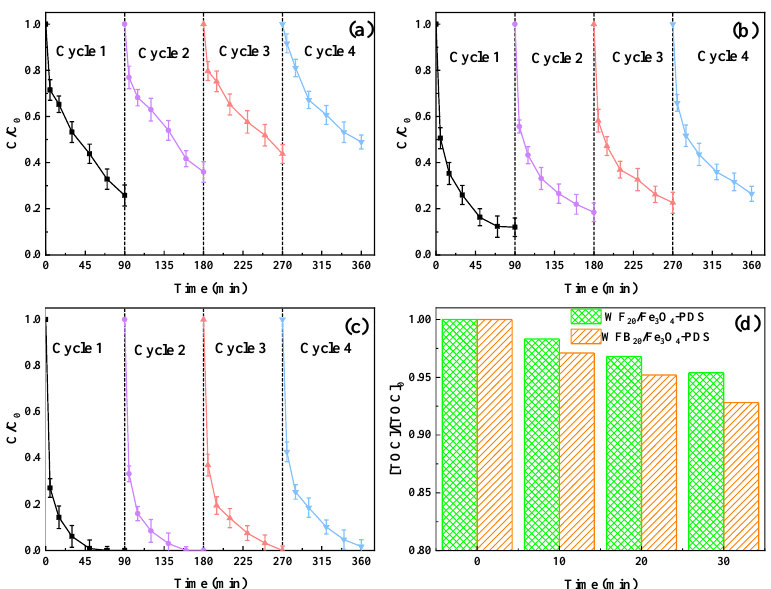
Figure 9. The removal performance of BPA in four consecutive runs in ( a ) Fe 3 O 4 -PDS, ( b ) WF 20 /Fe 3 O 4 /-PDS, and ( c ) WF 20 /Fe 3 O 4 -PDS processes; ( d ) the TOC removal performance of BPA in WF 20 /Fe 3 O 4 -PDS and WF 20 /Fe 3 O 4 -PDS processes (conditions: catalyst 1.0 g/L, [PDS] 0 = 5.0 mM, [BPA] 0 = 0.02 mM, pH 0 = 3.00 ± 0.1).